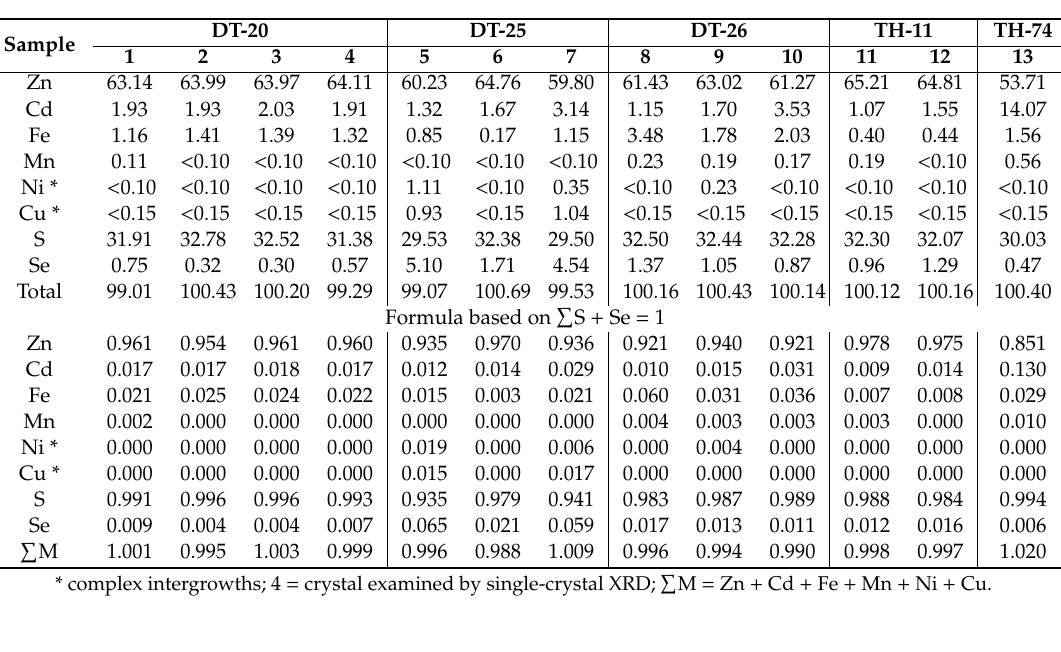
Table 9. Selected typical compositions of sphalerite from CM marbles, Tulul al Hammam area (EDS and EPMA data, wt%).